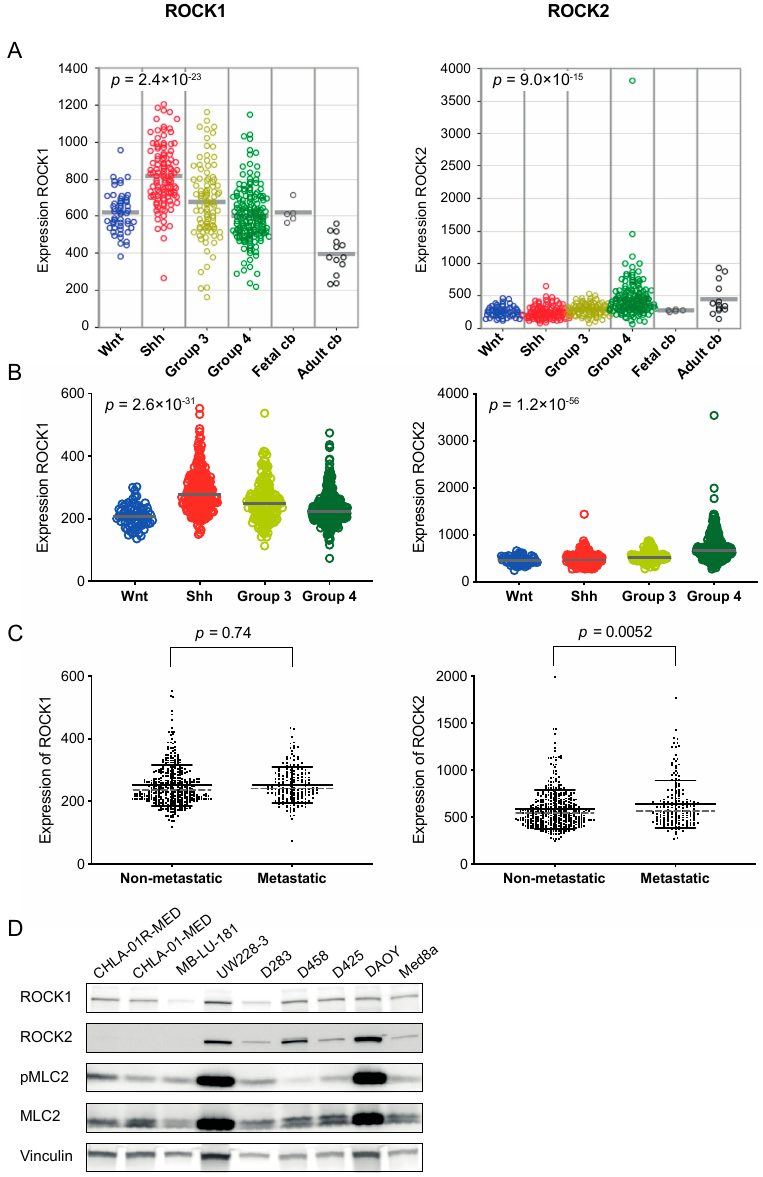
Figure 1. ROCK1 and ROCK2 are expressed in medulloblastoma tumors. ( A , B ) mRNA expression of ROCK1 and ROCK2 in medulloblastoma molecular subgroups (Wnt, Shh, Group 3 and Group 4) in two di ff erent patient cohorts and in fetal and adult cerebellum (cb) [20–23]. For the cohort shown in A, n = 423 primary medulloblastomas including Wnt n = 53, Shh n = 112, Group 3 n = 94 and Group 4 n = 164, plus fetal cb ( n = 5) and adult cb ( n = 13), and in B n = 763 primary medulloblastomas including Wnt n = 70, Shh n = 223, Group 3 n = 144 and Group 4 n = 326. P values from one-way ANOVA across the four medulloblastoma subgroups. Comparing ROCK1 expression in fetal cb tissue with medulloblastoma tumor samples showed no significant di ff erences except when compared to Shh medulloblastomas ( p = 0.0082). Moreover, all medulloblastoma subgroups displayed higher expression of ROCK1 than the adult cb (adult cb vs. all individual subgroup p < 0.001). For ROCK2 expression no di ff erences were detected between the medulloblastoma subgroups and fetal cb, however, adult cb showed higher expression than the Wnt, Shh and Group 3 subgroups (adult cb vs.